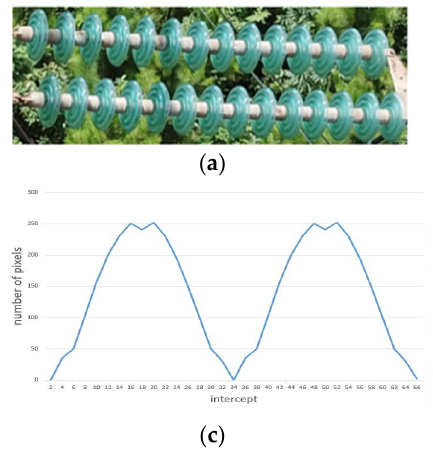
Figure 8. Finding the insulator cutting line: ( a ) target image; ( b ) binary image; ( c ) scan result; ( d ) cutting line.